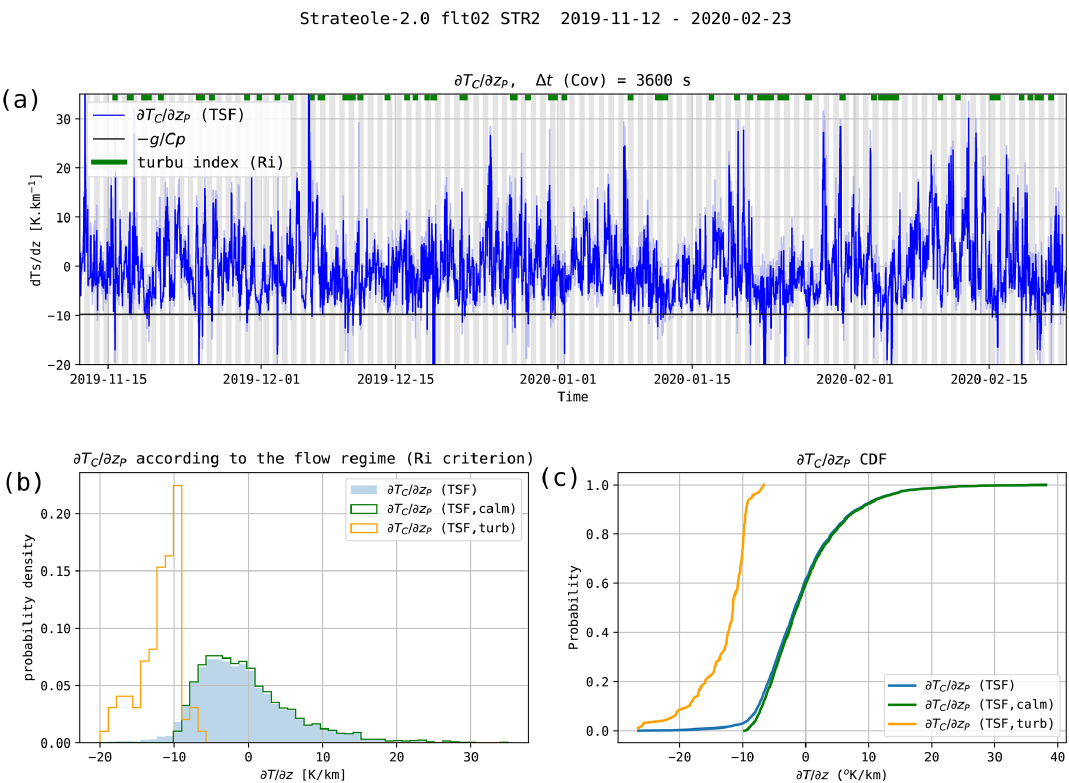
Figure 10. (a) Two estimates of ∂T C /∂z P for flight 02_STR2, from the linear fitting of T C and δz P at hourly intervals. The black line shows the adiabatic lapse rate − g/c P . The Ri turbulence index is drawn on the top of the figure as a thick green discontinuous line. (b) Histograms of ∂T C /∂z P for all of the time intervals (blue shading) and for the respective laminar and turbulent cases (thin lines). (c) CDFs of the temperature